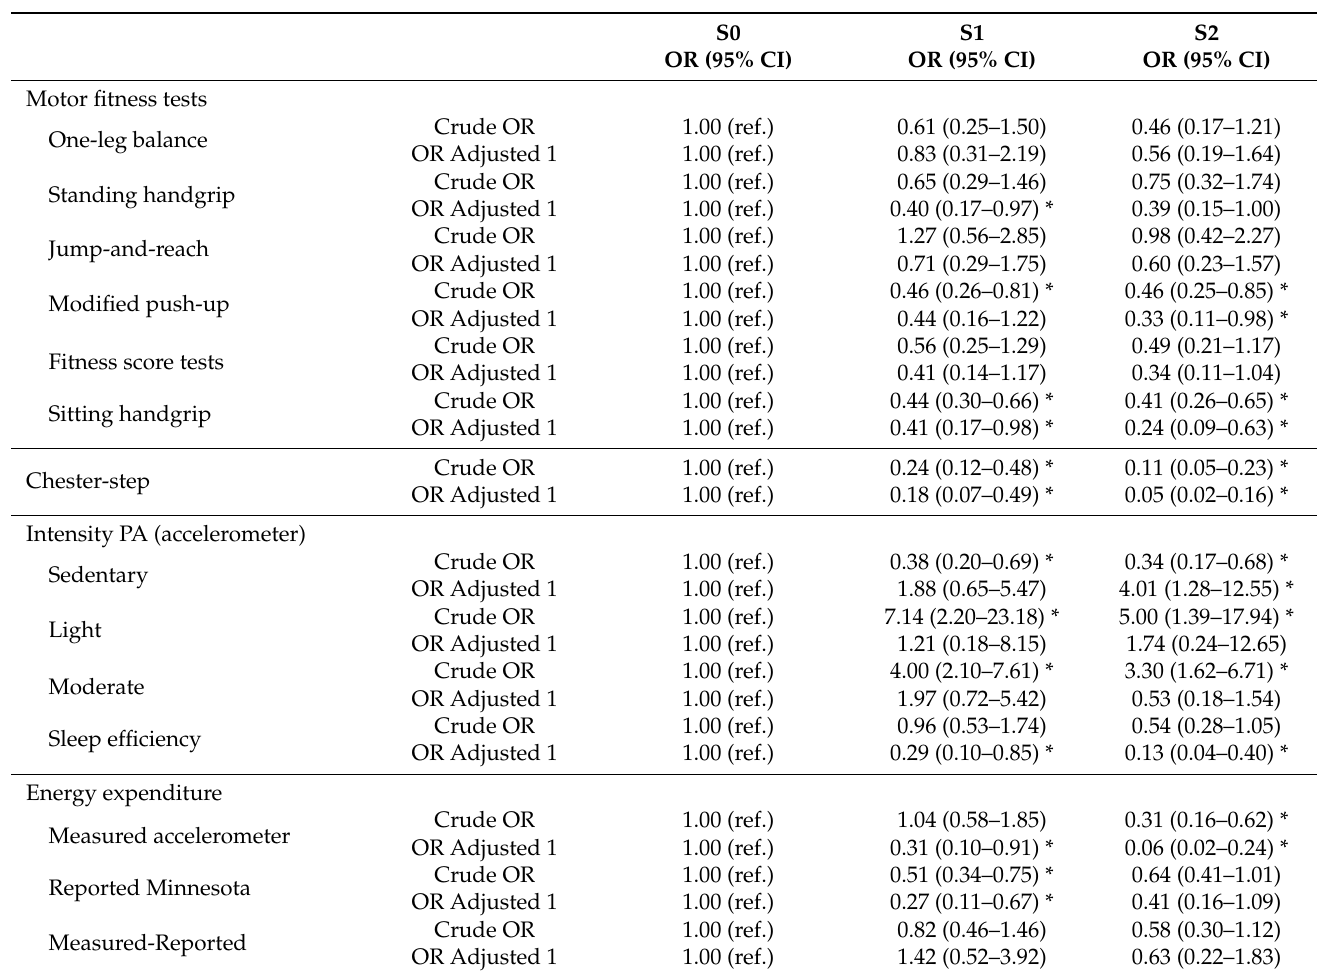
Table 3. Association between physical activity parameters (dependent variables) and stages of hepatic steatosis (independent